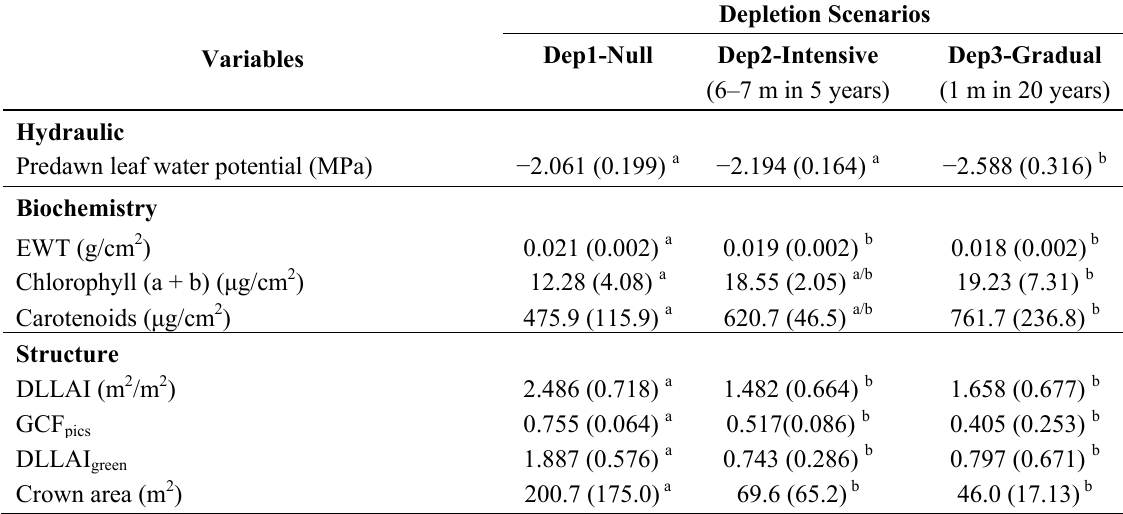
Table 4. Means and standard deviations (in brackets) of the hydraulic, biochemical and structural variables for Tamarugo trees under different groundwater depletion